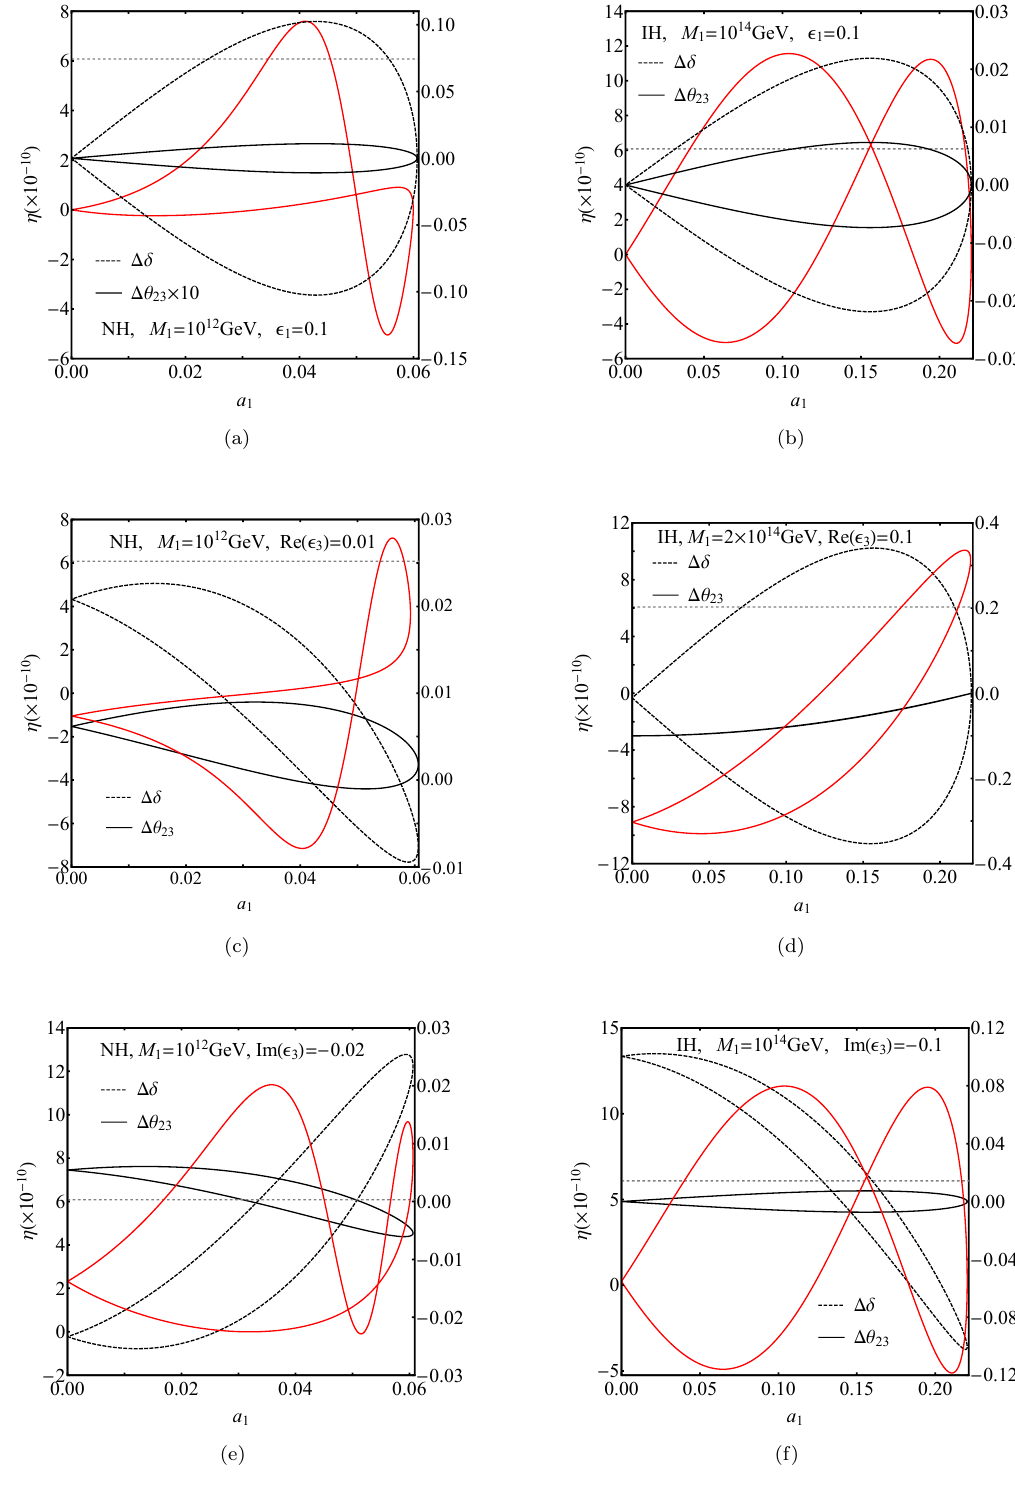
Figure 6 . The resulting (cid:1) (cid:14) and (cid:1) (cid:18) (cid:12)gure 4 that can lead to successful leptogenesis. The red line is used to denote the corresponding (cid:17) .